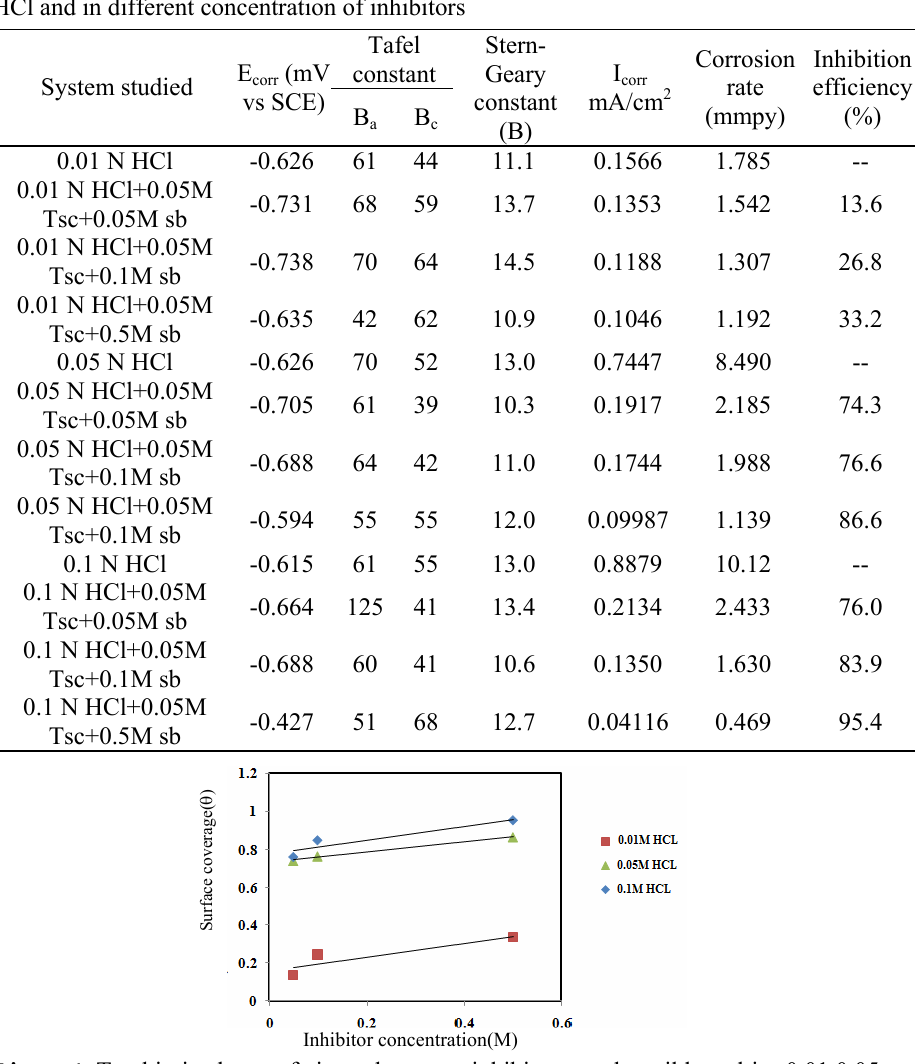
Figure 4. Temkin isotherm of citrate-benzoate inhibitors on the mild steel in 0.01,0.05 and 0.1 N HCl at 30 0